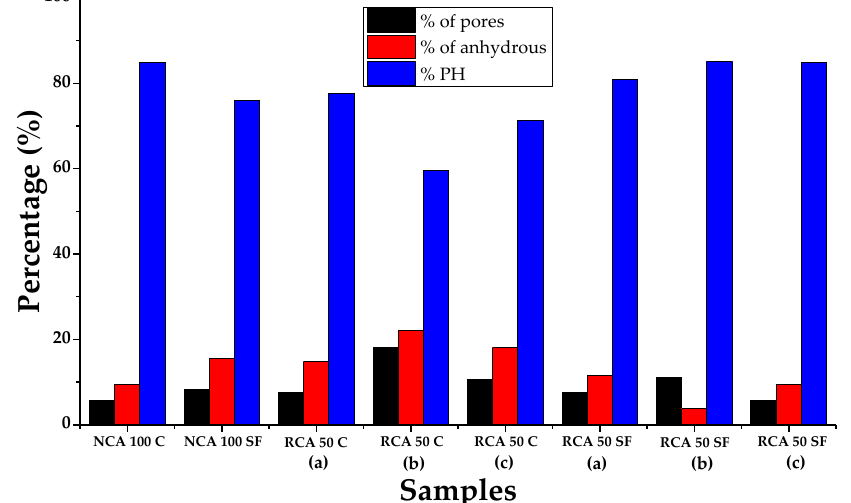
Figure 10. Porosity, anhydrous material and p H of the cement paste in the PC.